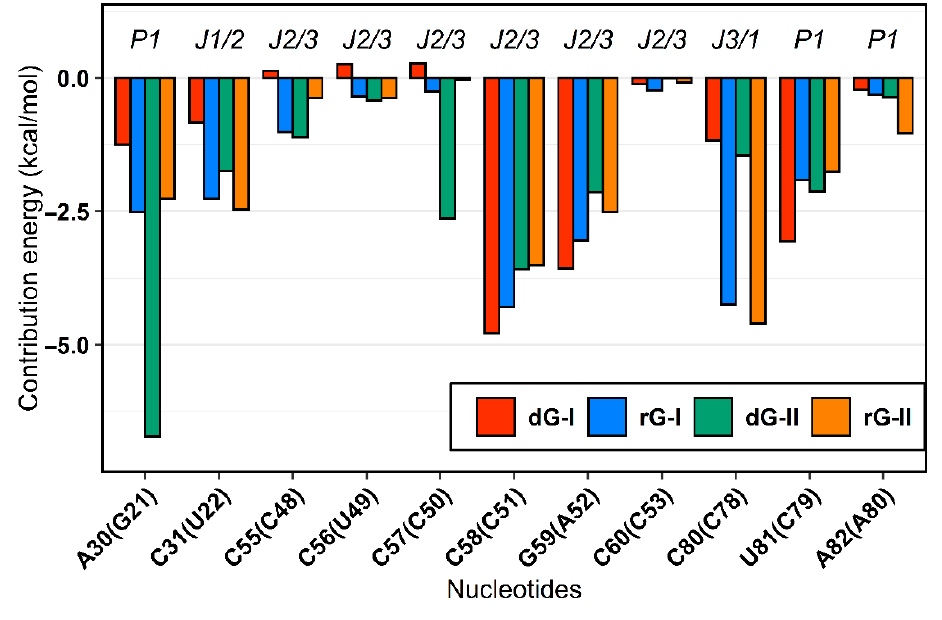
Figure 4. MM/GBSA per-nucleotide decomposition energies. Only nucleotides with energy less than zero were represented. The aptamer substructures are depicted at the top margin. Each system was colored according to the figure caption.